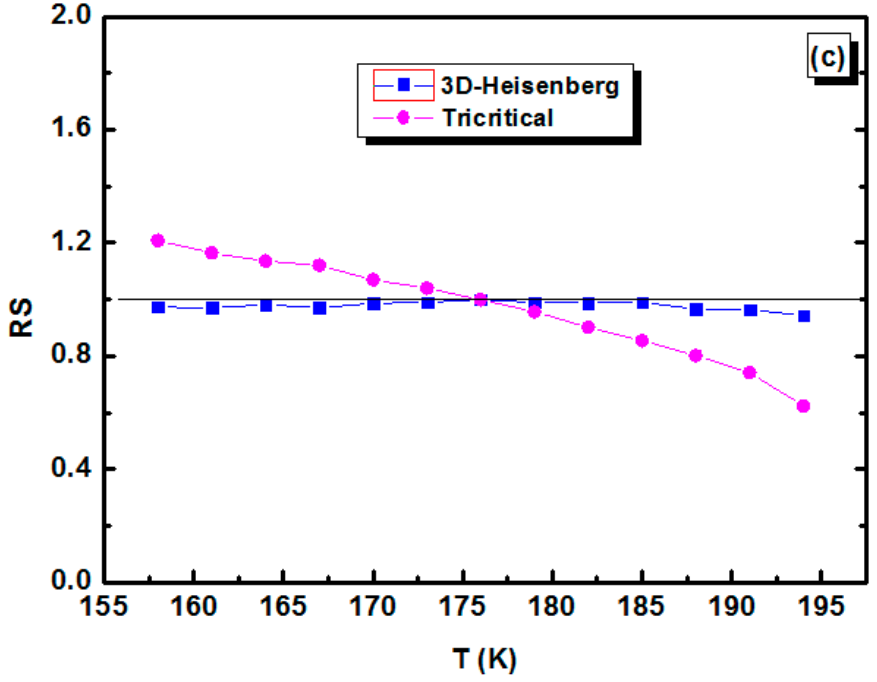
Figure 6. Relative slope (RS) as a function of temperature, defined as RS = S(T)/S( T C ), RS being the experimental slopes at high fields, for La 0.8 Ca 0.2 Mn 1 − x Co x O 3 . ( a ) x = 0.1; ( b ) x = 0.2; and ( c ) x = 0.3.